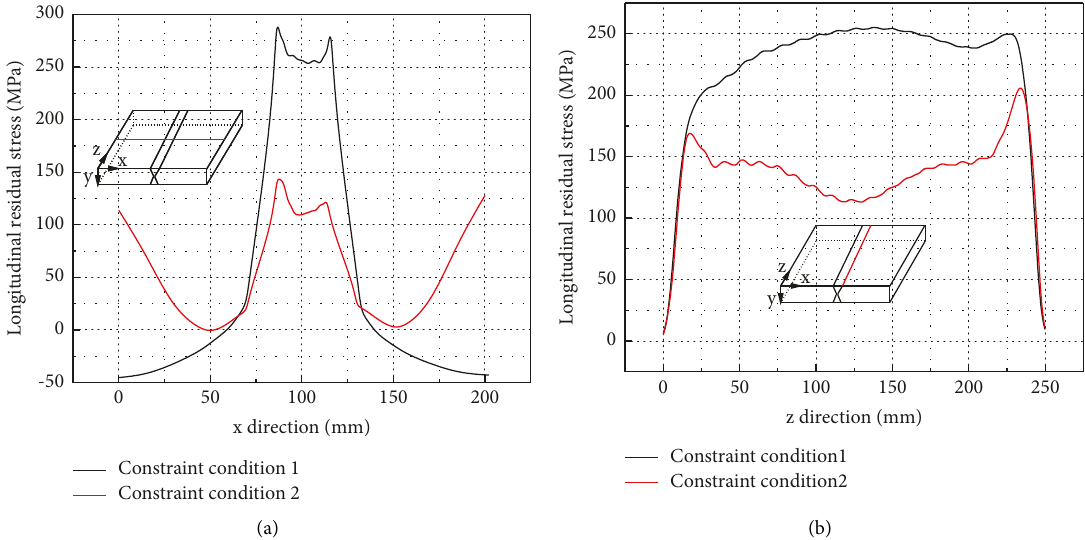
Figure 23: Effect of the constraint conditions on the longitudinal residual stress. (a) Longitudinal residual stress of path 1. (b) Longitudinal residual stress of path 2. Influence of the constraint condition on the welding